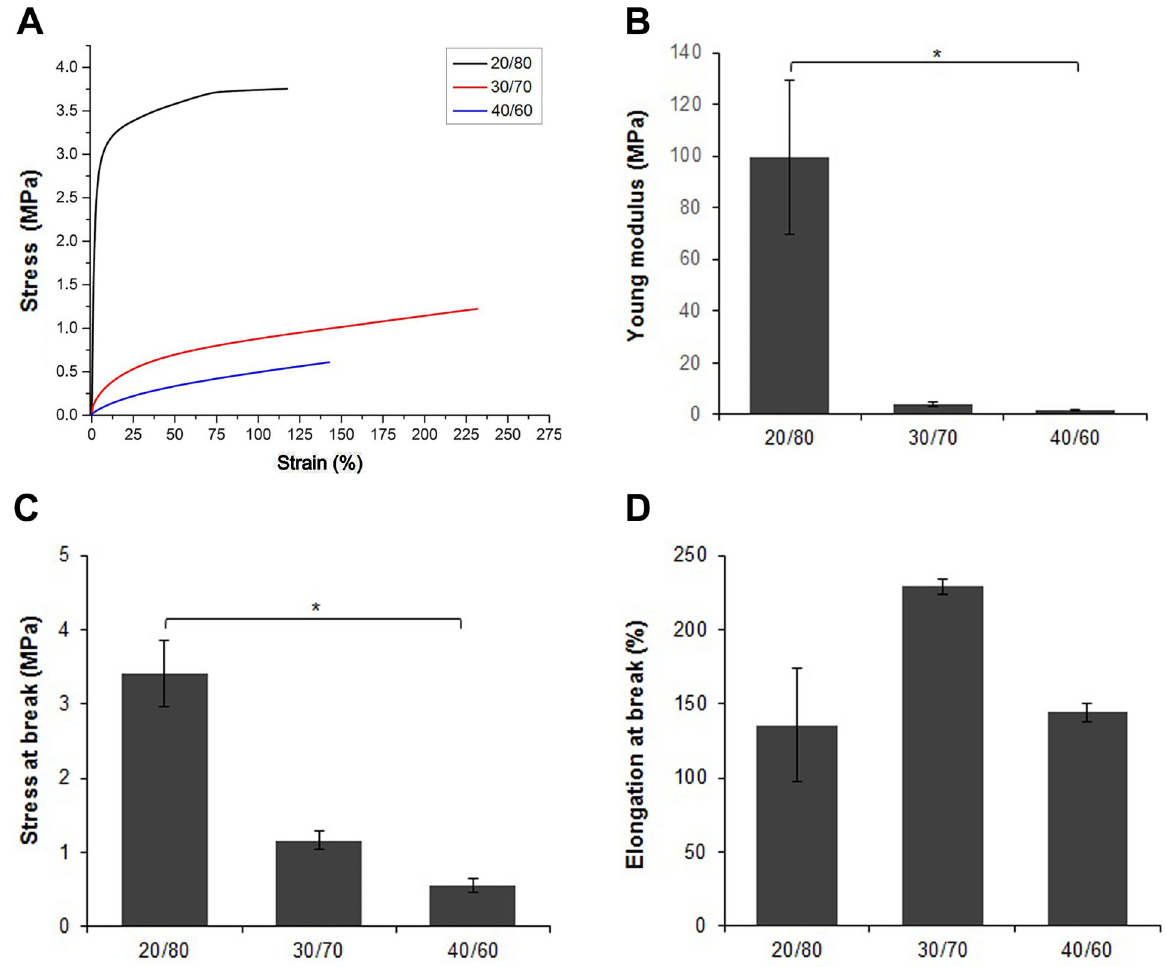
Figure 3. Mechanical properties of poly(trimethylene carbonate- co -L-lactide) (PTMCLLA) 20/80, 30/70, and 40/60 scaffolds. Stress- strain representative curve ( A ), Young modulus ( B ), stress at break ( C ), and elongation at break ( D ). Data are reported as means ± SD. *P o 0.05 between the groups (Kruskal-Wallis followed by Dunn ’ s